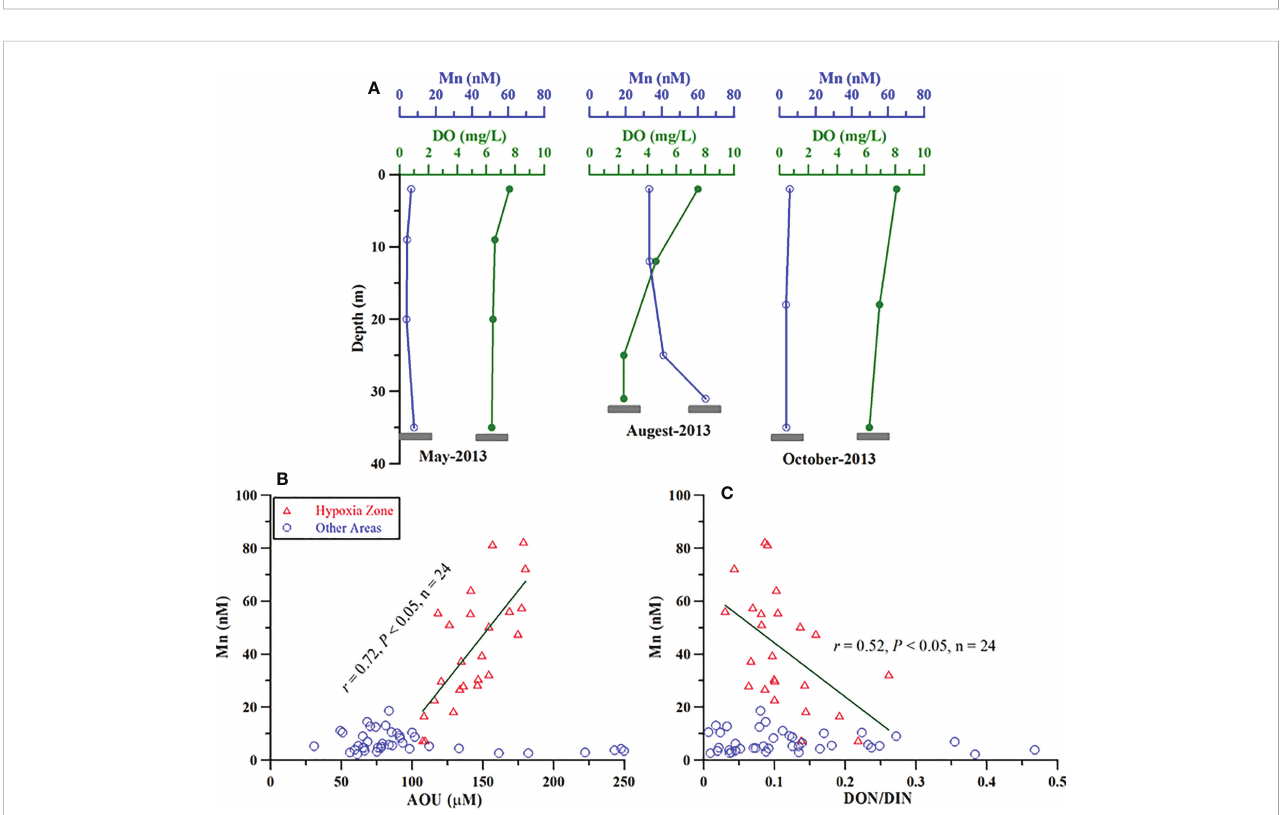
FIGURE 10 Comparison of seasonal pro fi les of dissolved oxygen and dissolved Mn at station N4 in the Changjiang Estuary (A) . Bottom dissolved Mn concentration plotted as a function of AOU (B) and DON/DIN (C) . The hypoxic zone is emphasized with a red